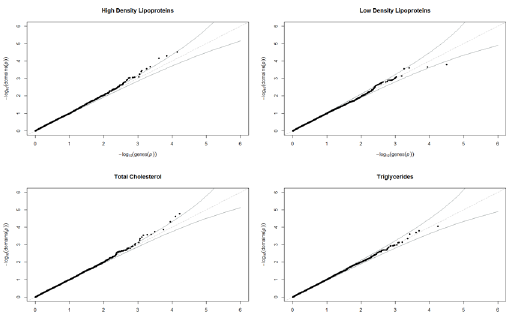
Fig 2. Quantile-Quantile plots to compare distributions of p-values identified using individual domain and gene-based approaches to rare variant analysis. These Q-Q plots represent the distribution of p- values from an analysis where rare variants have been collapsed together using protein domain coordinates and analysed with lipid traits. The reference distribution for these plots are distributions of p-values from an identical analysis except collapsing rare variants using conventional gene-based